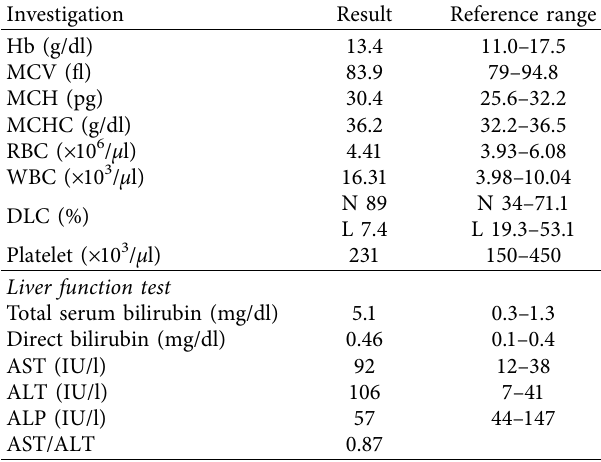
Table 1: Laboratory investigations of the patient.